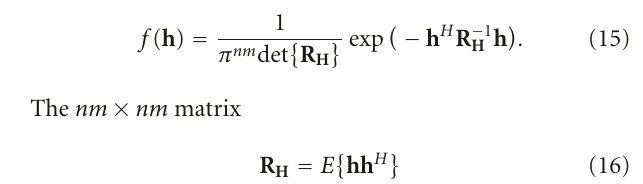
Figure 5: Example for equivalent scatterer ( (cid:2) ) in the uplink of a system with multiple element BS antenna (true scatterers shown as (cid:8)